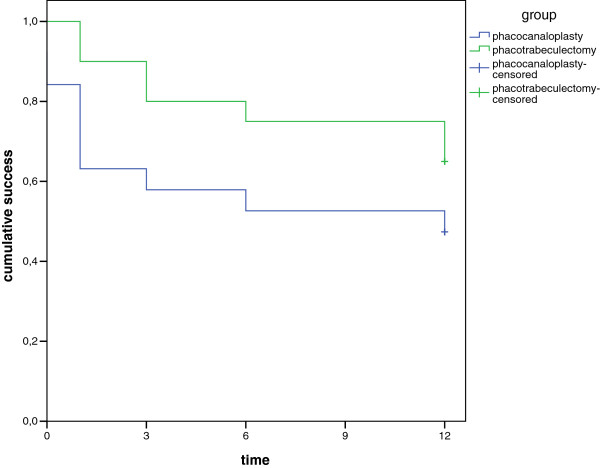
Kaplan-Meier survival plot for cumulative probability of complete success. Success was defined as an intraocular pressure (IOP) of less than 18 mmHg without glaucoma medication (complete success). Censored data occurred if a patient completed the 12-month visit and maintained an IOP of less than 18 mmHg without glaucoma medication over 12 months. In the phacocanaloplasty group, the line starts below 1.0 because 2 patients developed a filtering bleb in the early postoperative period and were countered as a failure.